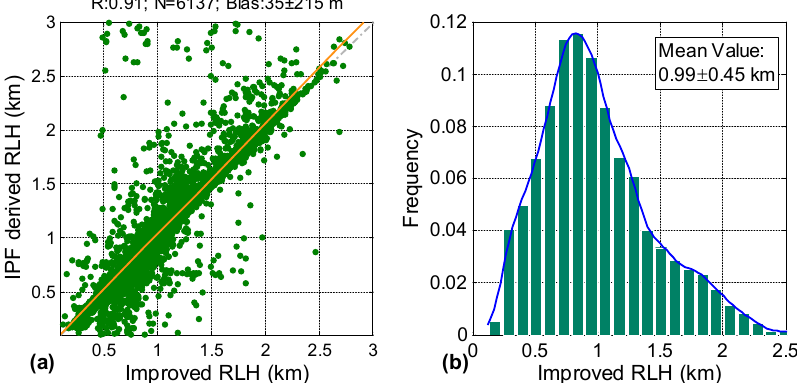
Figure 7. ( a ) Comparison of RLHs derived with the improved and IPF methods; ( b ) Frequency distribution of RLHs derived with the improved method. The blue solid line represents the fitting curve.